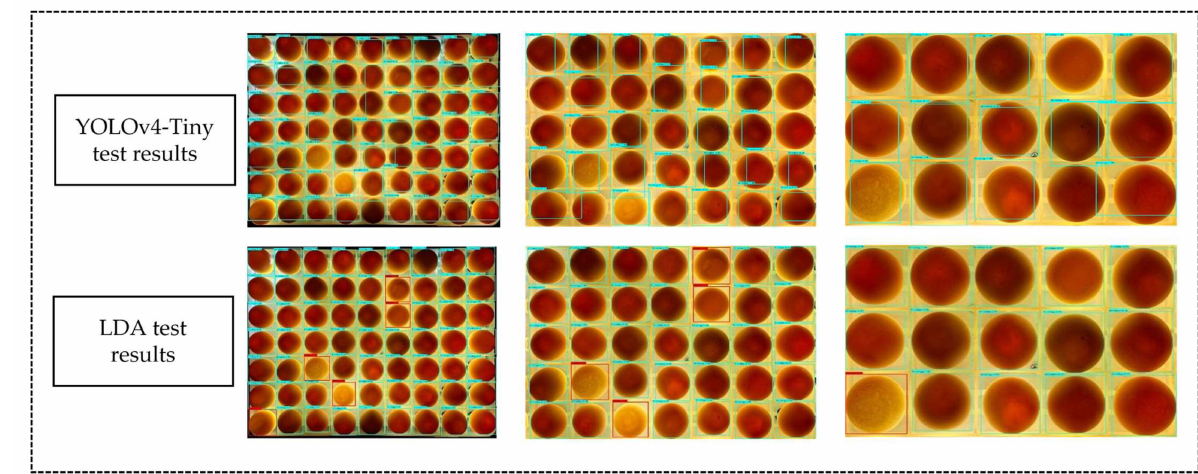
Figure 8. Detection